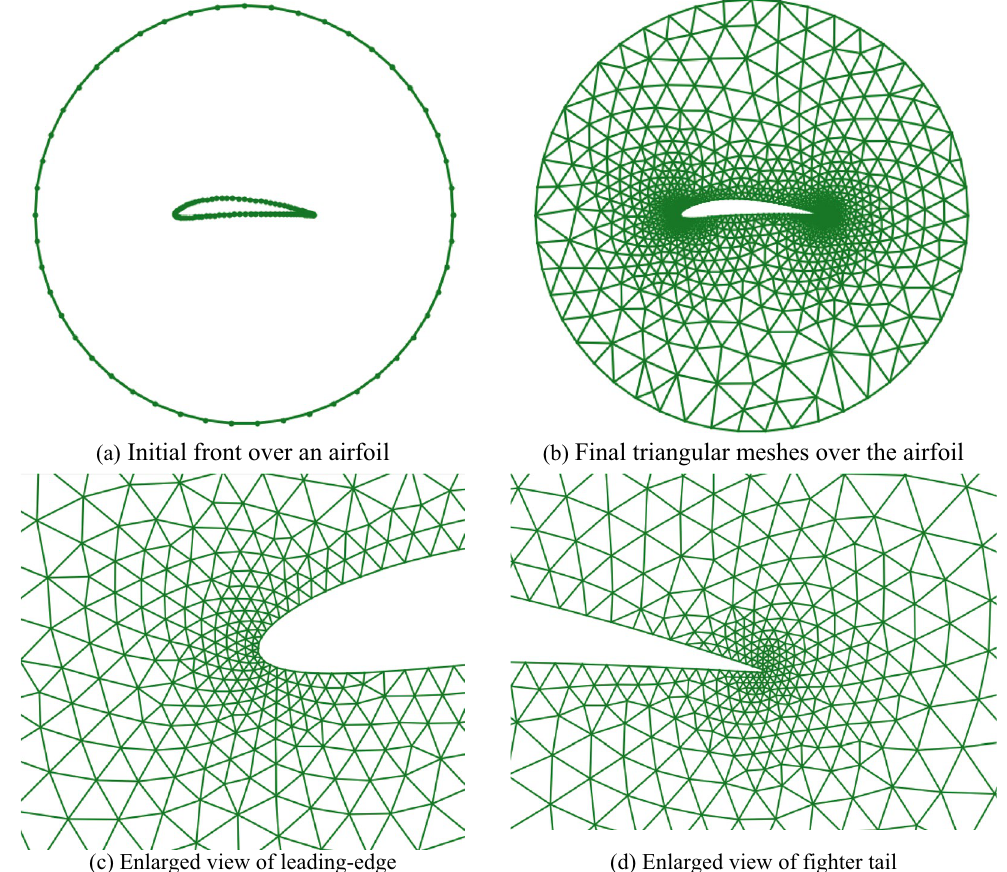
Figure 16. Mesh generation over an airfoil4.3 30P30N three-element